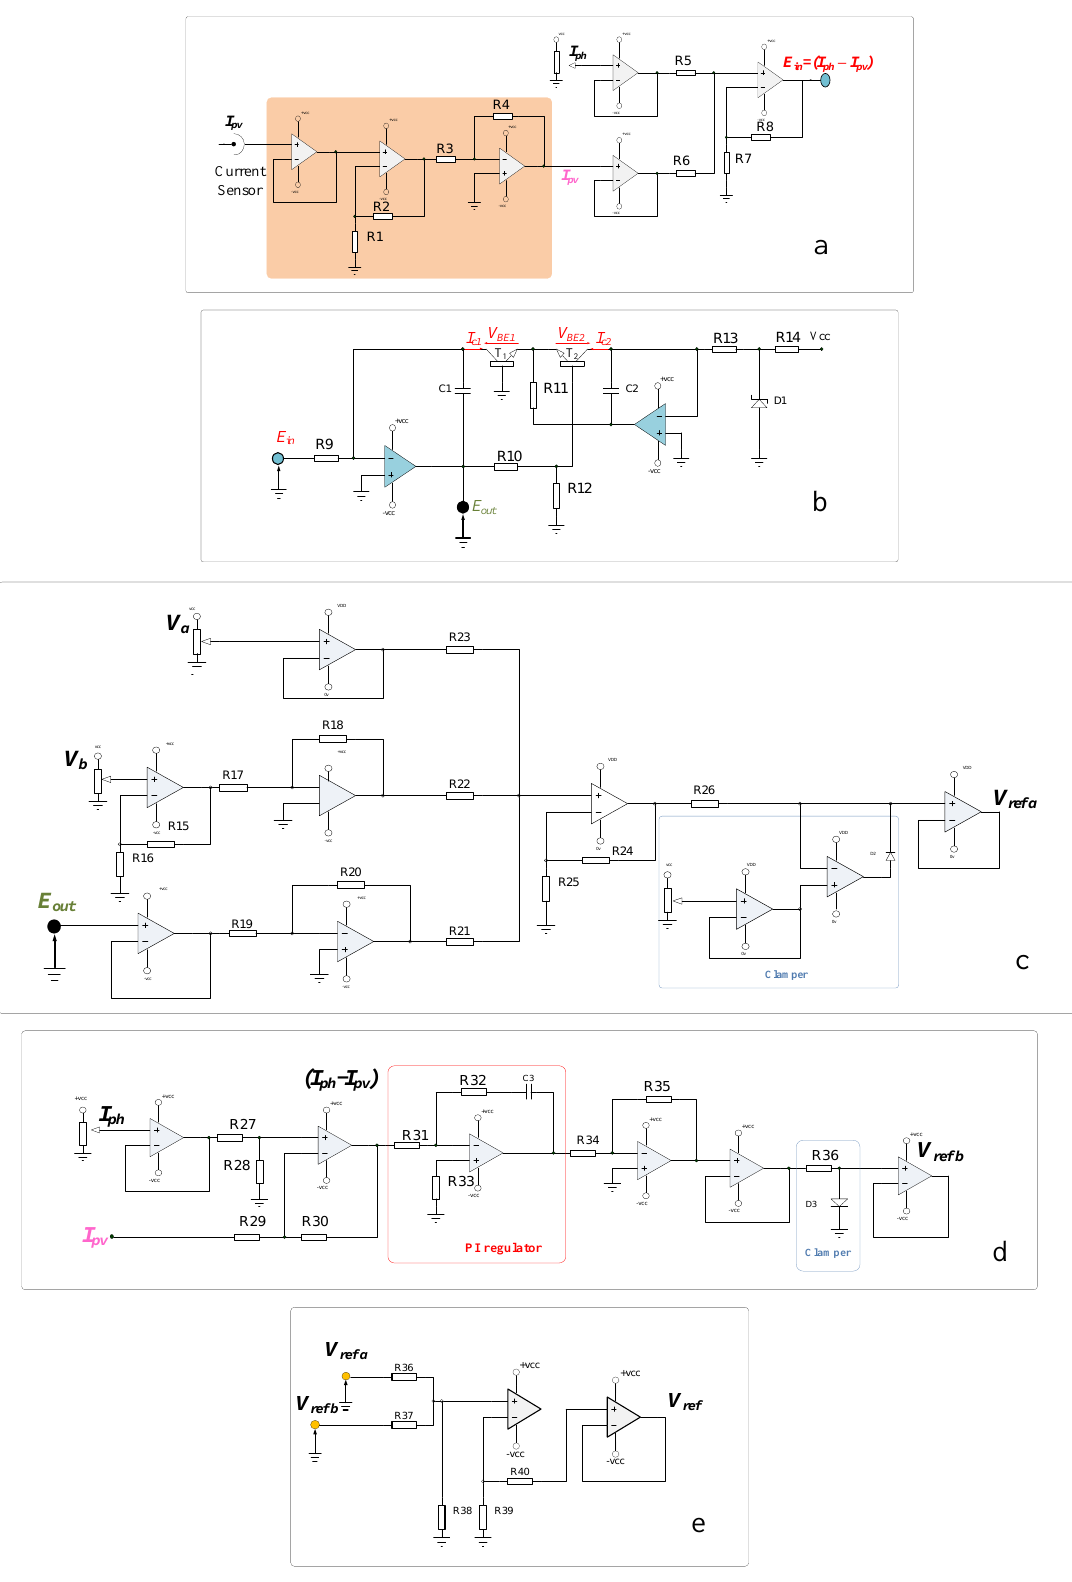
Figure 9. Electrical schematic analog components of the PV emulator controller legend: ( a ) Treatment circuit. ( b ) Logarithmic amplifier circuit. ( c ) PV characteristic voltage. ( d ) PI controller circuit. ( e ) comparator circuit.